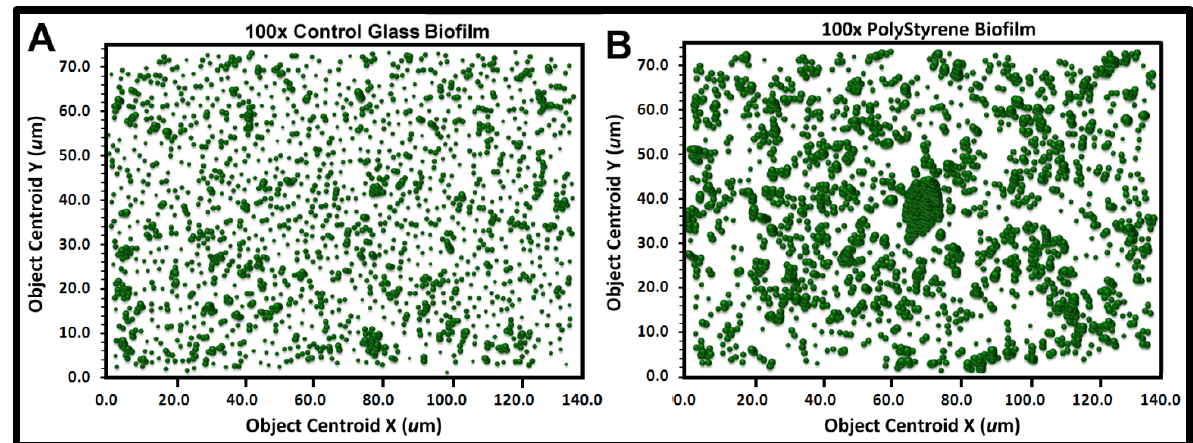
Figure 9. Georeferenced bubble plots of the biofilm landscapes containing community A ( a ) and B ( b ). The distribution of each individual bacterial cell is represented as a 3-dimensional bubble whose width is weighted by its Cluster index. Note the larger aggregated bubbles for the biofilm assemblage of community B.